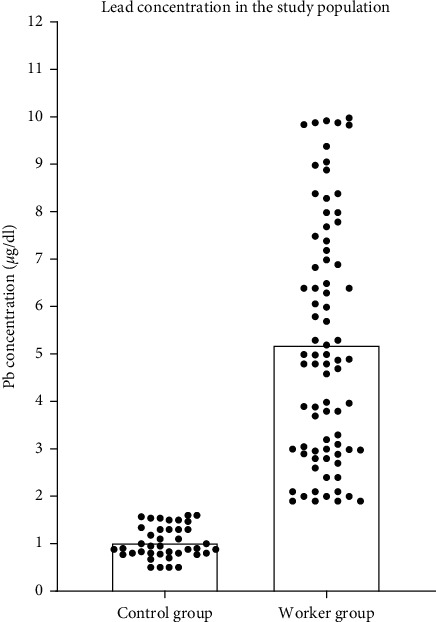
The concentration of lead in the wastewater treatment plant workers is almost five times higher than the amount found in the control group (P < 0.0001).